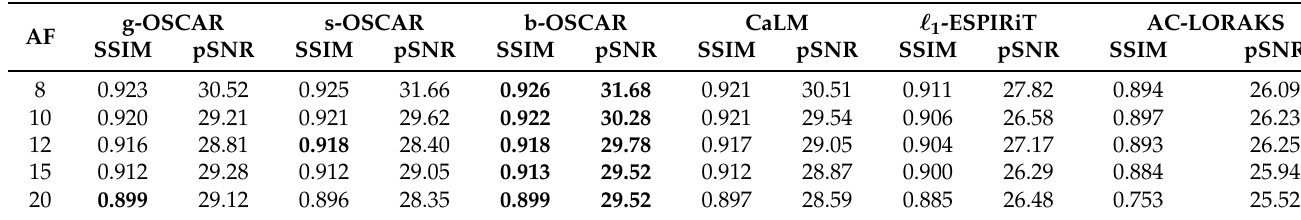
Table 2. Comparison of different OSCAR-norm regularizations with (cid:96) 1 -ESPIRiT, CaLM and AC-LORAKS. The hyper- parameters were set to maximize the SSIM score. Best image quality metrics computed per row appear in bold font. At most, three scores are outlined on each